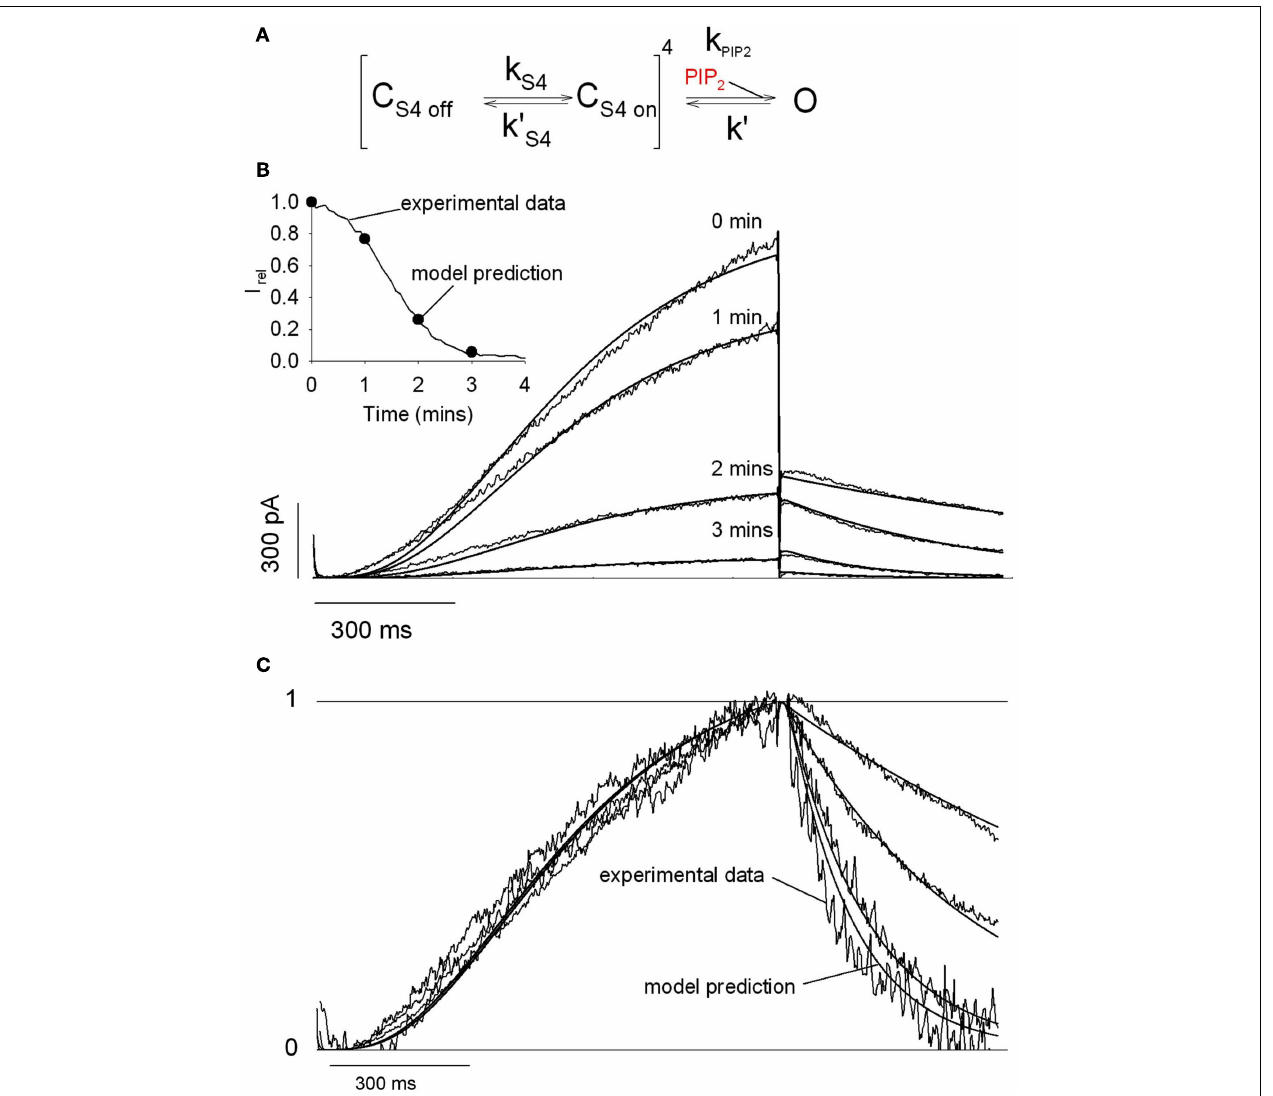
superimposed with the simulated current (solid lines). k PIP2 was fixed to FIGURE 2 |A model based on the stabilization of the open state by PIP2 592.74, 176.43, 25.84, and 4.53/s (simulating PIP 2 level decrease) to best fit recapitulates the characteristics of the KCNQ1/KCNE1 currents. (A) During activation, k (cid:48) is negligible whereas k S4 = 3.56/s, and during the decrease in current amplitude during rundown, as shown in the inset. s4 = 7.47 / s whereas k Inset: simulated (circles) and observed current (solid line) amplitudes as a deactivation k (cid:48) S4 is negligible. In this model, PIP 2 only s4 affects the transition from a closed state to an open state when the four function of time after patch excision. (C) Traces in (B) were normalized to voltage sensors are in the permissive state ( C S4on ).Thus, during simulated compare the observed and simulated kinetics of activation and deactivation. rundown, only k PIP2 varies ( k (cid:48) = 87.3/s). (B) Experimental traces were From Loussouarn et al.